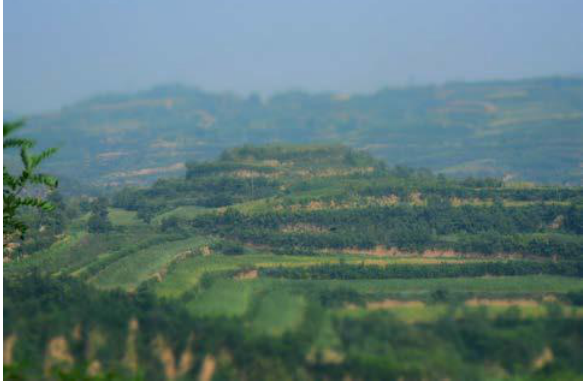
Figure 1. Landscapes in